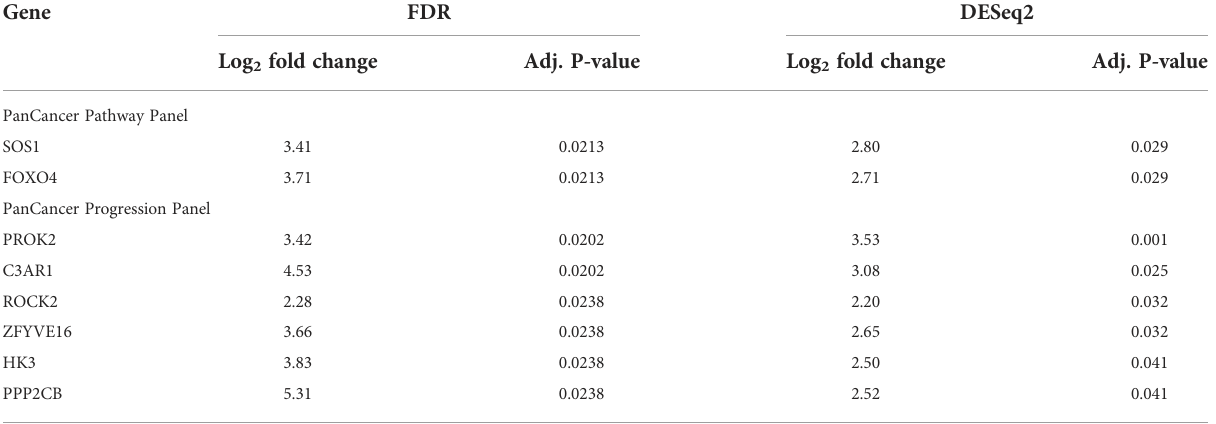
TABLE 1 Genes signi fi cantly differentially expressed in patients with bone marrow metastases versus patients without bone marrow metastases, commonly identi fi ed by FDR and DESeq2 differential expression analyses. Gene FDR Log 2 fold